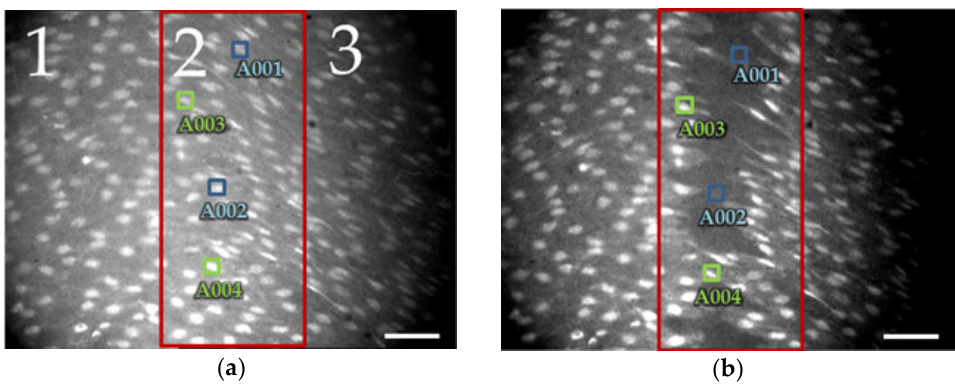
Figure 3. Images from mechanical stimulus experiment. ( a ) Before and ( b ) after the tissue injury. Suggested zones for the analysis (1, 2 and 3). Blue ROIs, A001 and A002 in ( a ) shown cells in the injured zone that were damaged by the tip of glass micro-pipette and lost Fura-2 fluorescence and then die and disappeared (( b ) blue ROIs, A001 and A002); these ROIs were marked as OFF-LINE cells. Green ROIs, A003 and A004, enclosed cells adjacent to the injured area, which have partially lost the contact with neighboring ECs, but preserved Fura-2 fluorescence after injury (( b ) green ROIs, A003 and A004); considered as ON-LINE cells. Bar length is 40 μm.